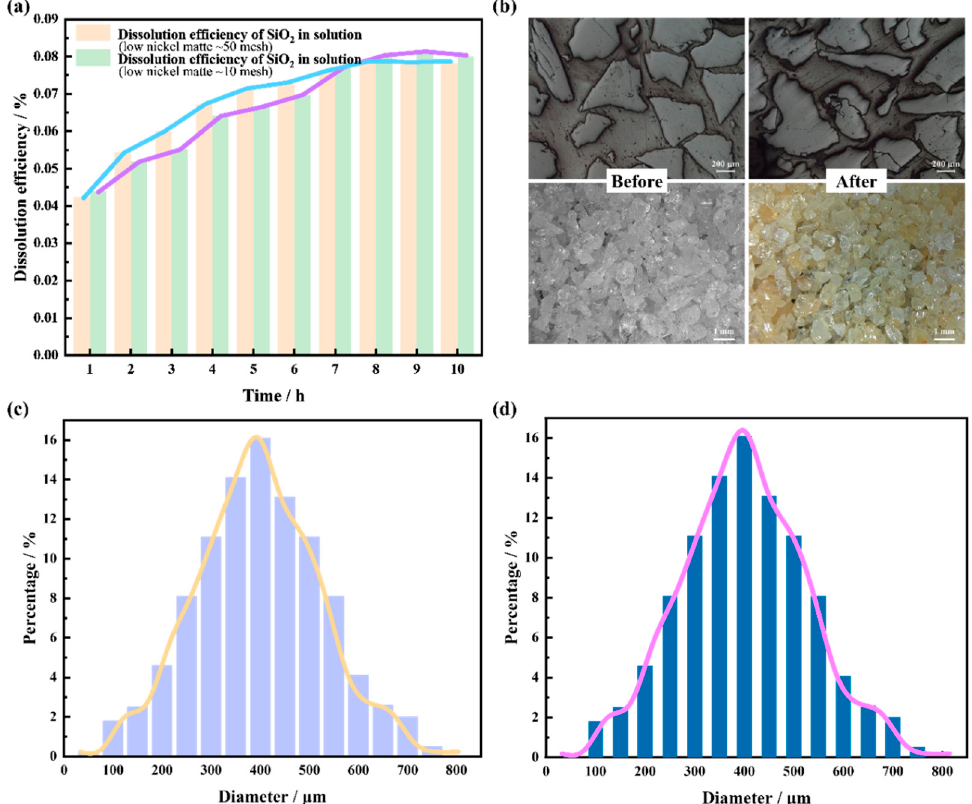
Figure 10. Characterization of quartz sand: ( a ) Dissolution efficiency of quartz sand in the low-nickel matte leaching process; ( b ) metallographic and digital photographs of quartz sand before and after the leaching process; ( c , d ) particle size statistics of quartz sand before and after the leaching process, respectively.